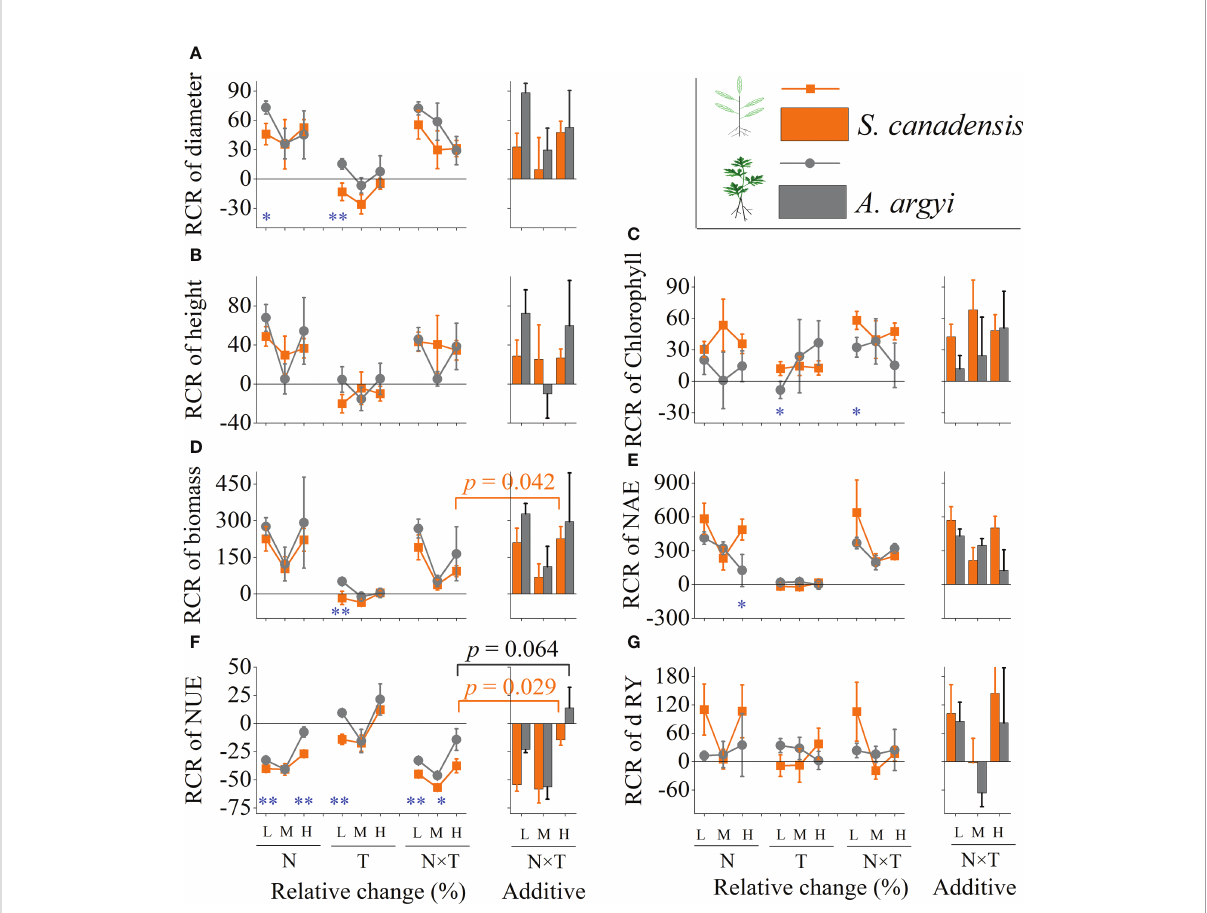
FIGURE 2 Effects of nutrient level (N) and warming (T) on the relative change ratio (RCR) of phenotypic traits of invasive S. canadensis and native A. argyi under different proportions in microcosm. Where (A – G) indicates the RCR of diameter, height, Chlorophyll, biomass, nitrogen absorption ef fi ciency (NAE), nitrogen use ef fi ciency (NUE) and relative yield (RY) of both species, respectively. Values are presented as relative change ratio (RCR) means ± SE. L, M, and H indicate low, moderated, and high invasion levels. * and ** indicate the signi fi cant level p < 0.1 and 0.05, respectively. The additive effect was the sum of the N addition and warming alone effects; the other difference is not presented for clarity.